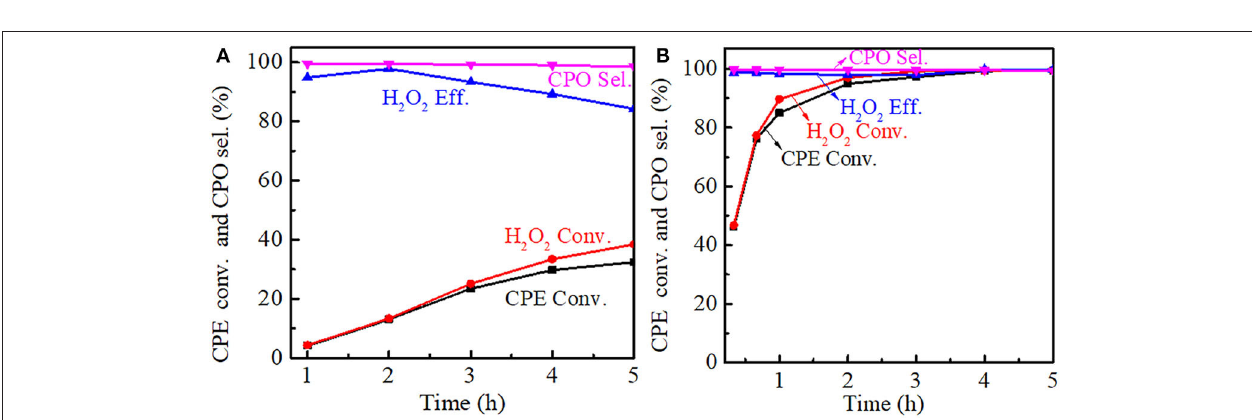
the CPO selectivity and H 2 O 2 efficiency gradually